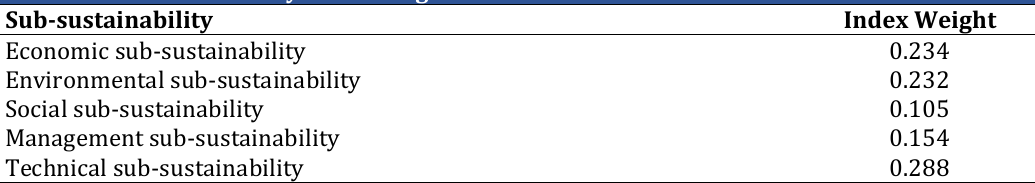
Table 8: Sub-sustainability index weights